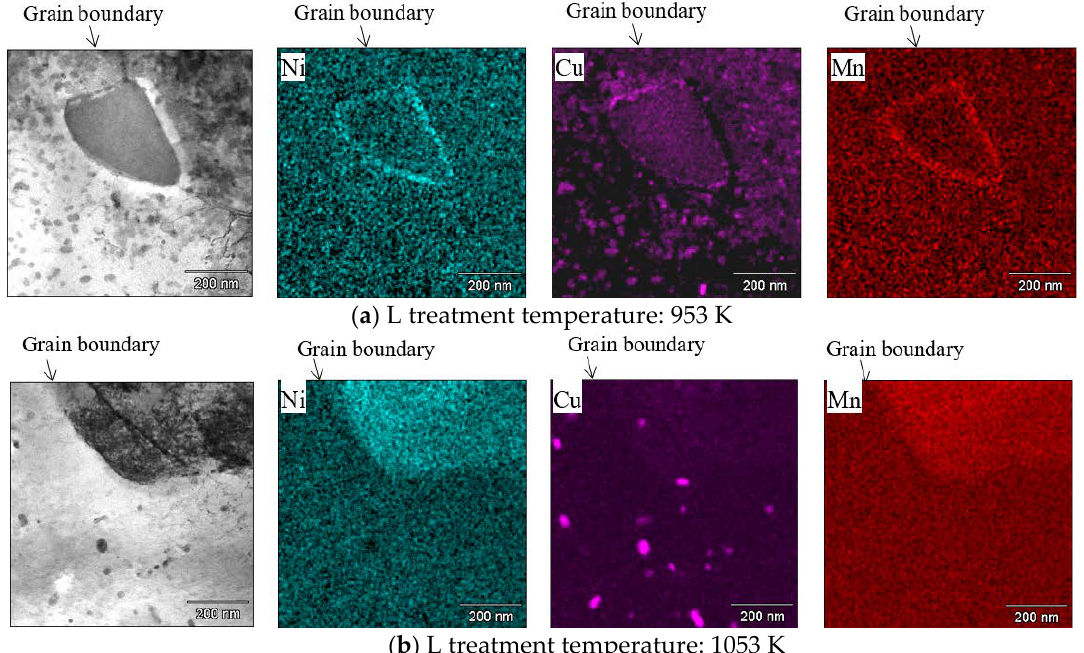
Figure 10. Element mapping images of TEM-EDS of Q–L samples heated to 950 K ( a ) and 1053 K ( b ).